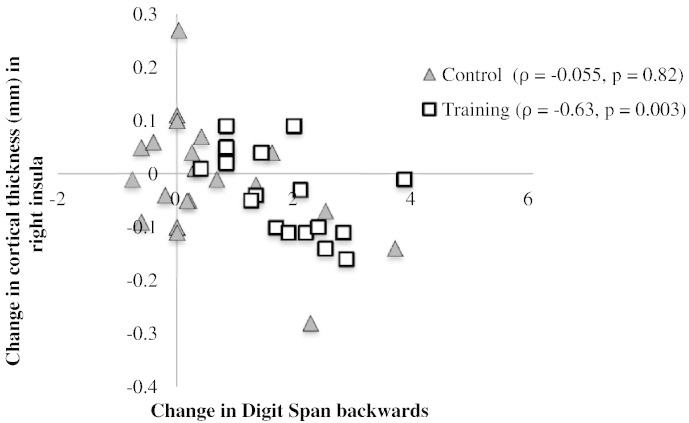
Negative Spearman rho correlation between changes in the thickness of the right insula and performance changes in the backward digit span task for the training group (white squares) compared to no correlation in the control group (grey triangles). The two correlation coefficients differed significantly (z = − 1.96, p = 0.025). All data were inspected for outliers defined as two standard deviations from the mean score (n = 19 in each group).